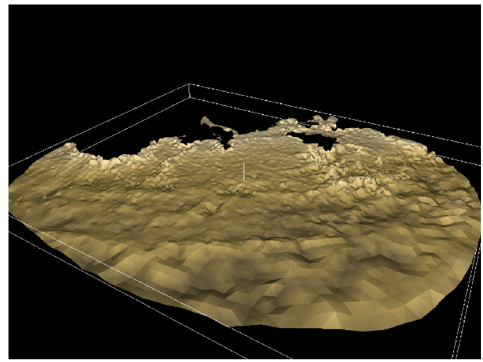
Figure 5. Terrain of the study area.